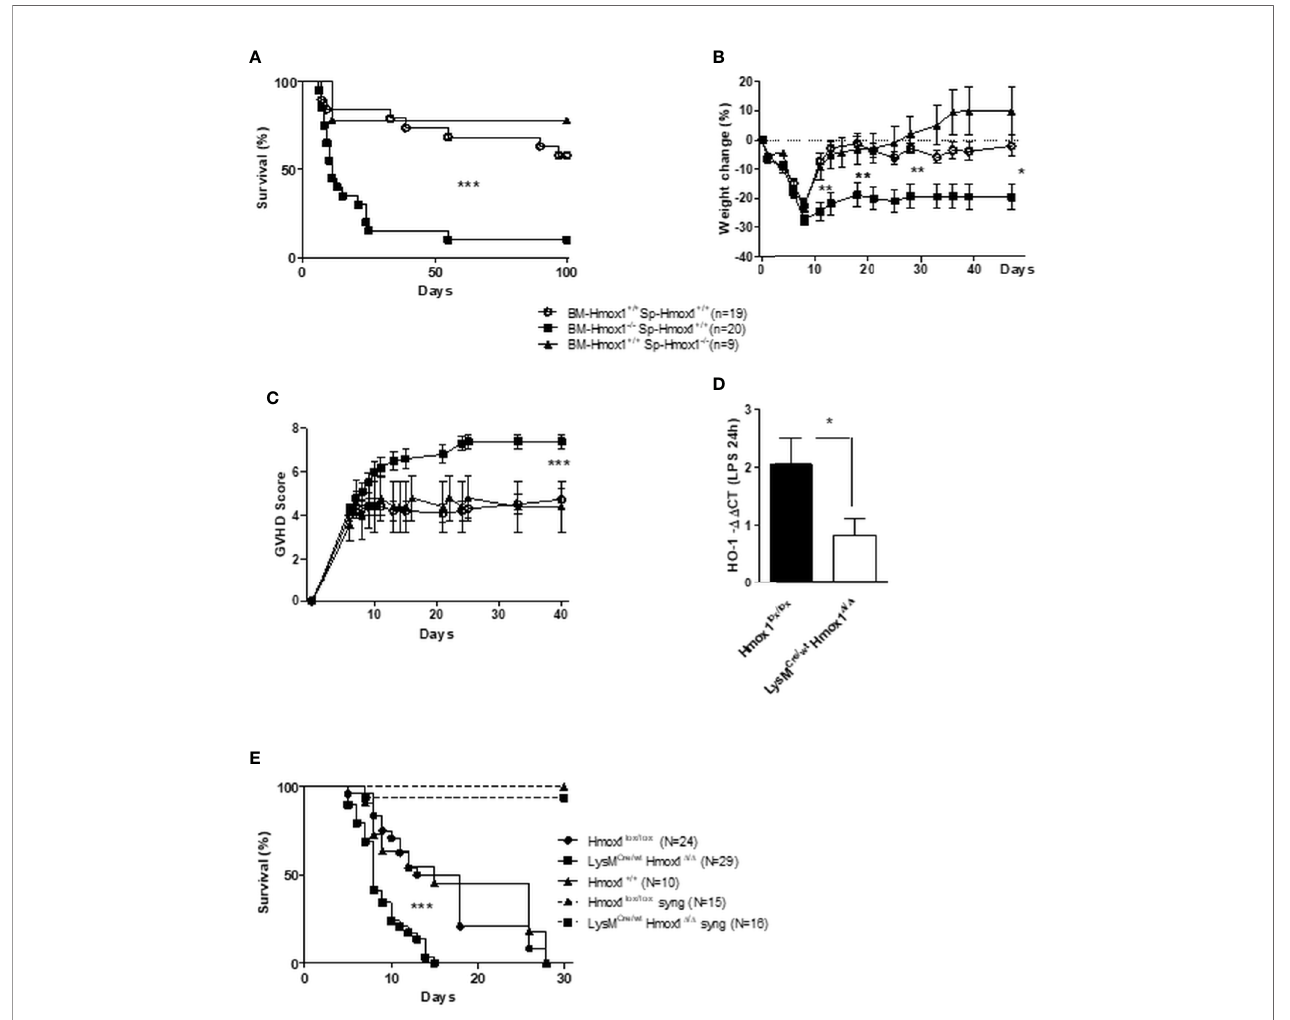
FIGURE 2 | Myeloid HO-1 but not T cell-derived HO-1 regulates GVHD. Survival (A) , weight change (B) and GVHD score (C) were compared between C57BL/6 irradiated hosts transplanted with a mix of BM and T cells from wild type ( Hmox1 +/+ ) BALB/c donors, with a mix of Hmox1 − / − BM and Hmox1 +/+ BALB/c T cells,